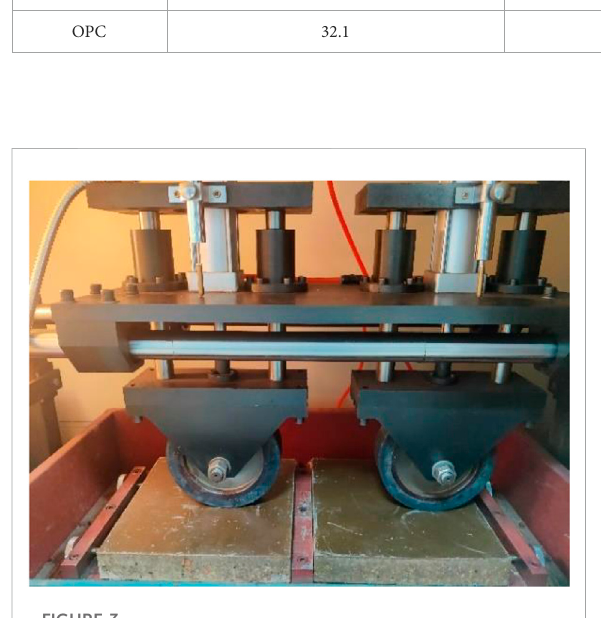
FIGURE 3 The schematic diagram of the gradient concrete test block. FIGURE 4